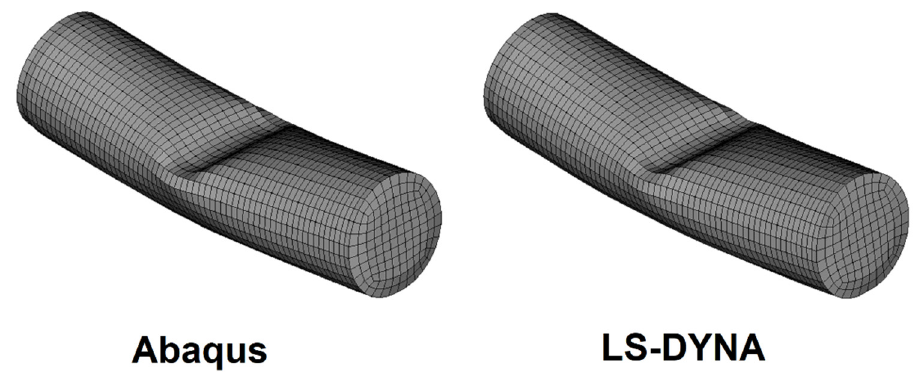
Figure 10. Simulation of deformation—load-case radial crush impactor.